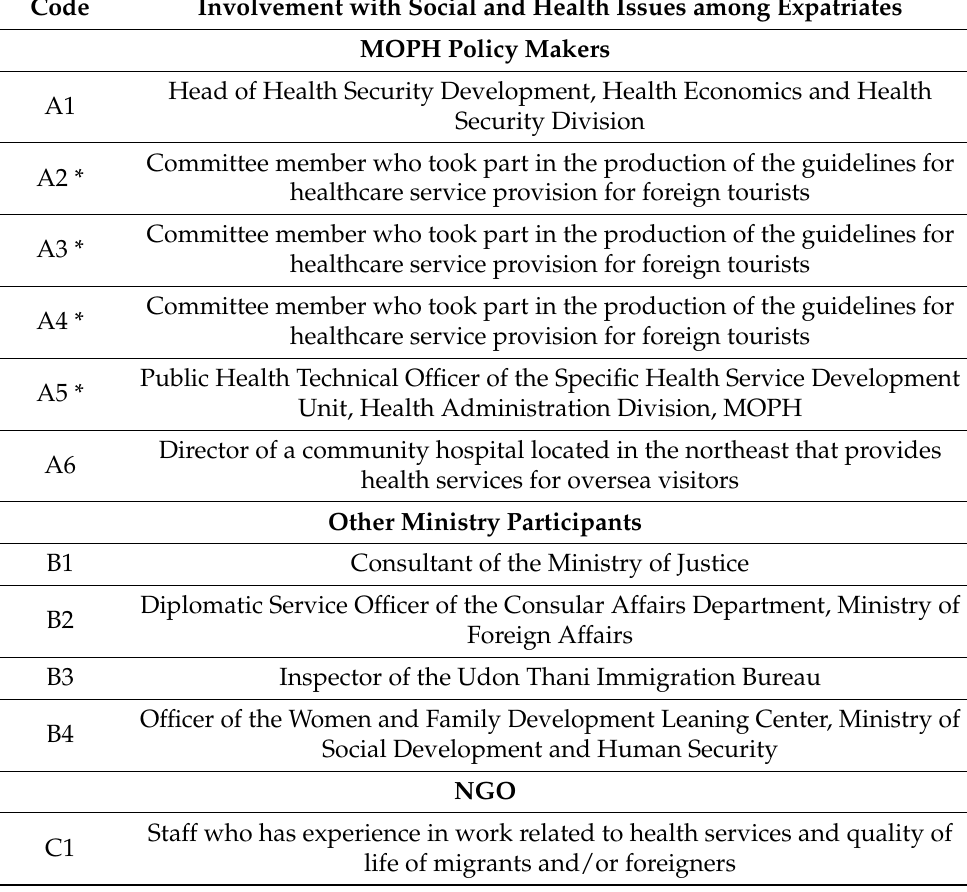
Table 1. List of interviewees about health status and barriers to foreigners’ healthcare access.